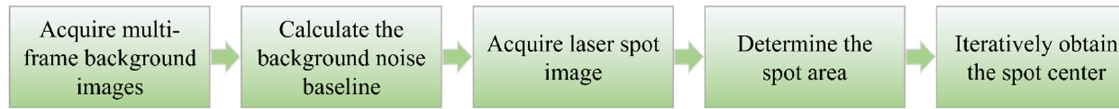
Figure 2. Realization of spot center detection.